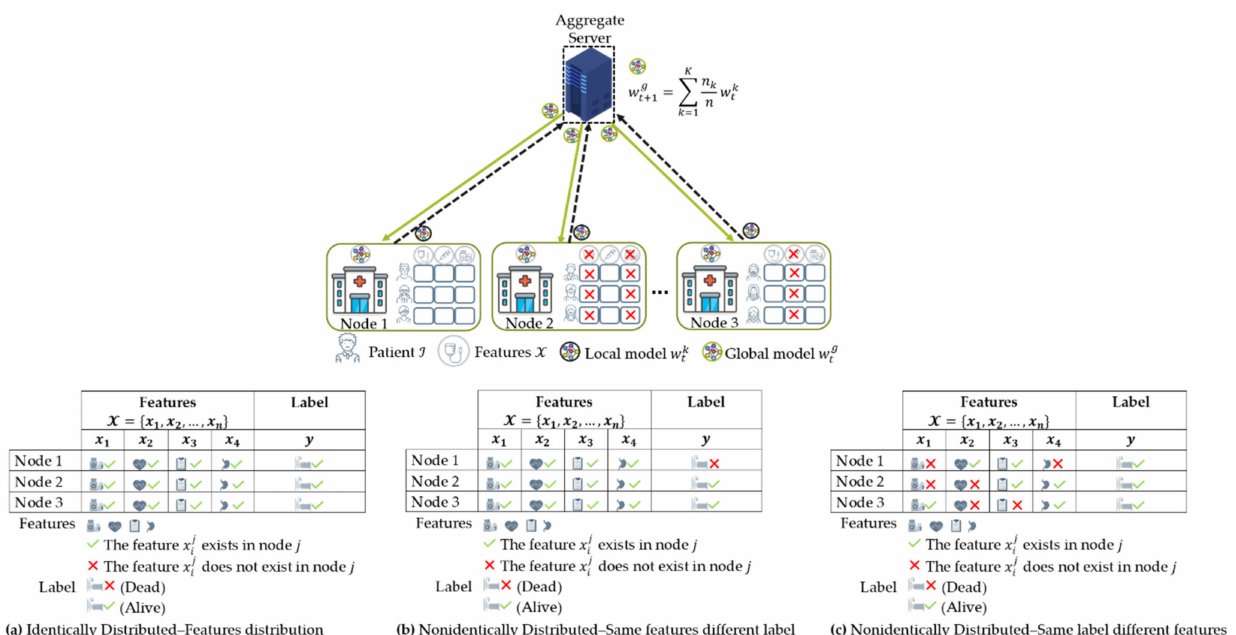
Figure 12. Non-IID from concept shift skew characteristic. ( a ) IID case; ( b ) non-IID same features but different label case; ( c ) non-IID same label but different features